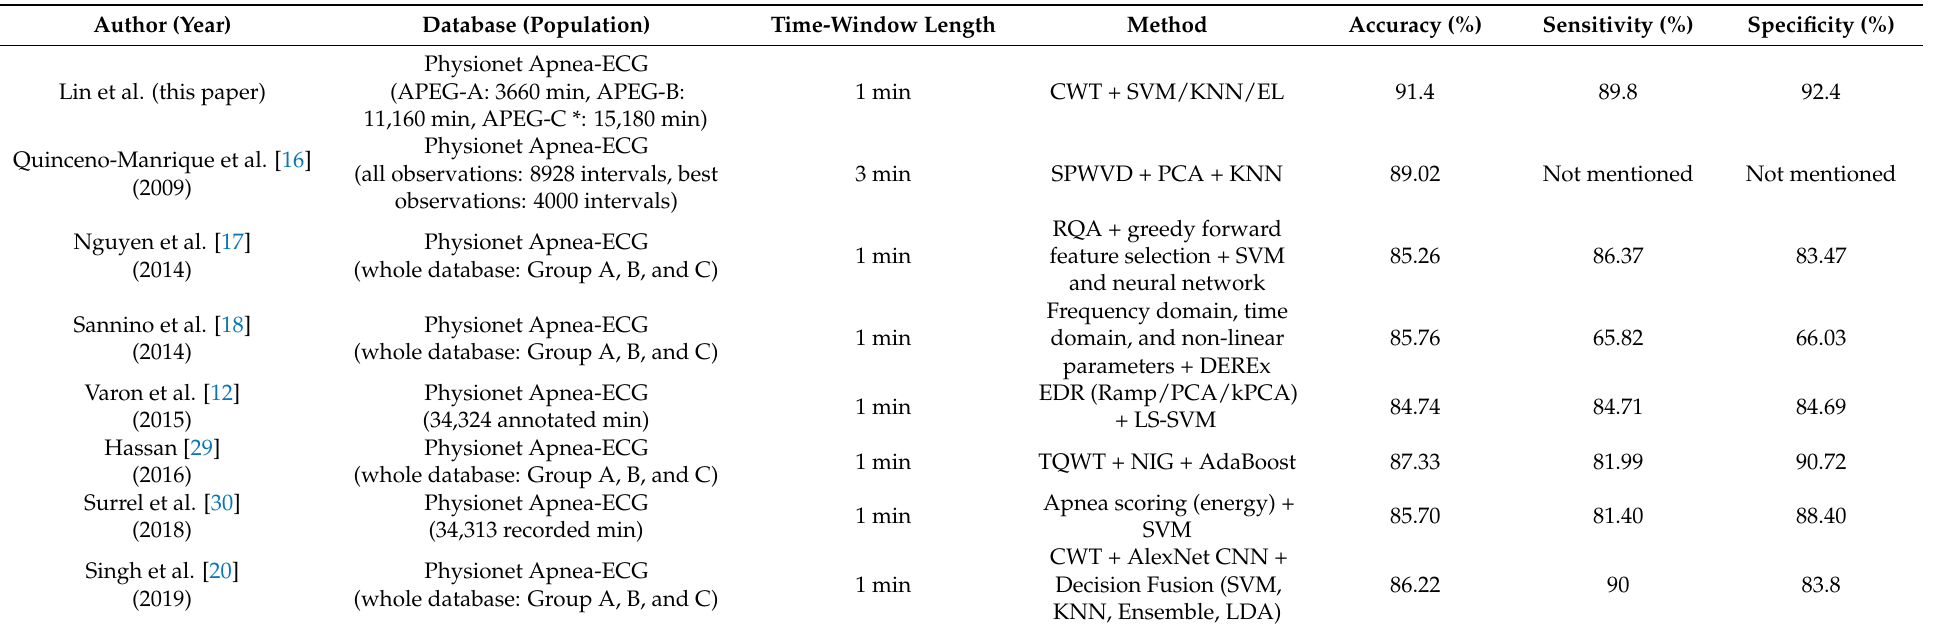
Table 11. Proposed algorithm comparison with current best-practice